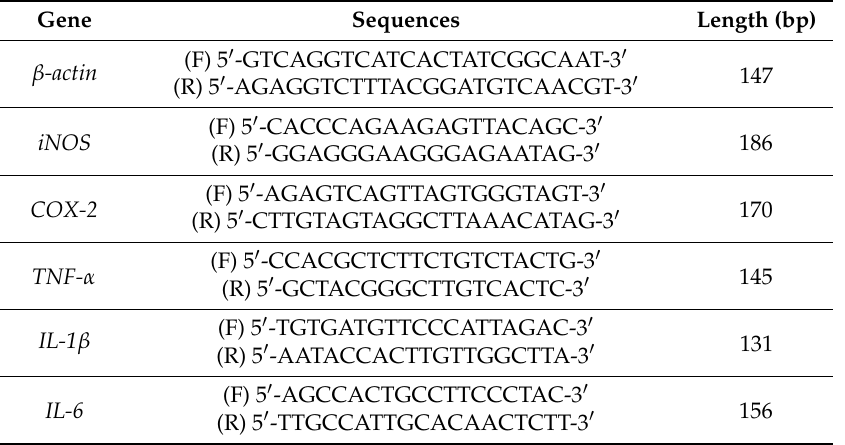
Table 2. Primers of rat for real-time